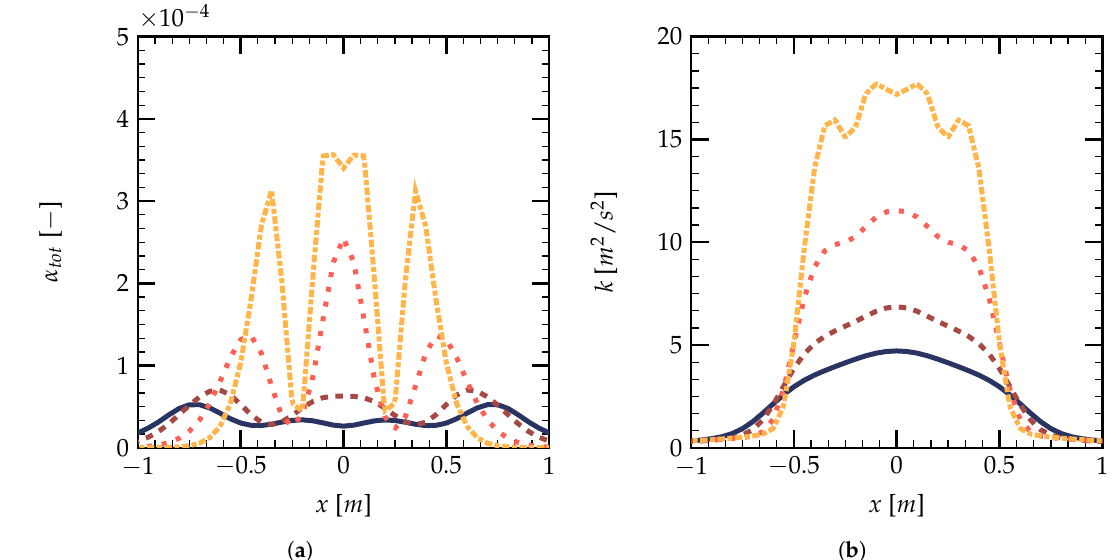
Figure 16. Evolutions of the droplet volume fraction α tot ( a ) and the turbulent kinetic energy k (m 2 /s 2 ) ( b ) on the XY plane y = 0.05 m as a function of x , h = 0.2 m ( ), h = 0.5 m ( ), h = 1.0 m ( ), and h = 1.5 m ( ).